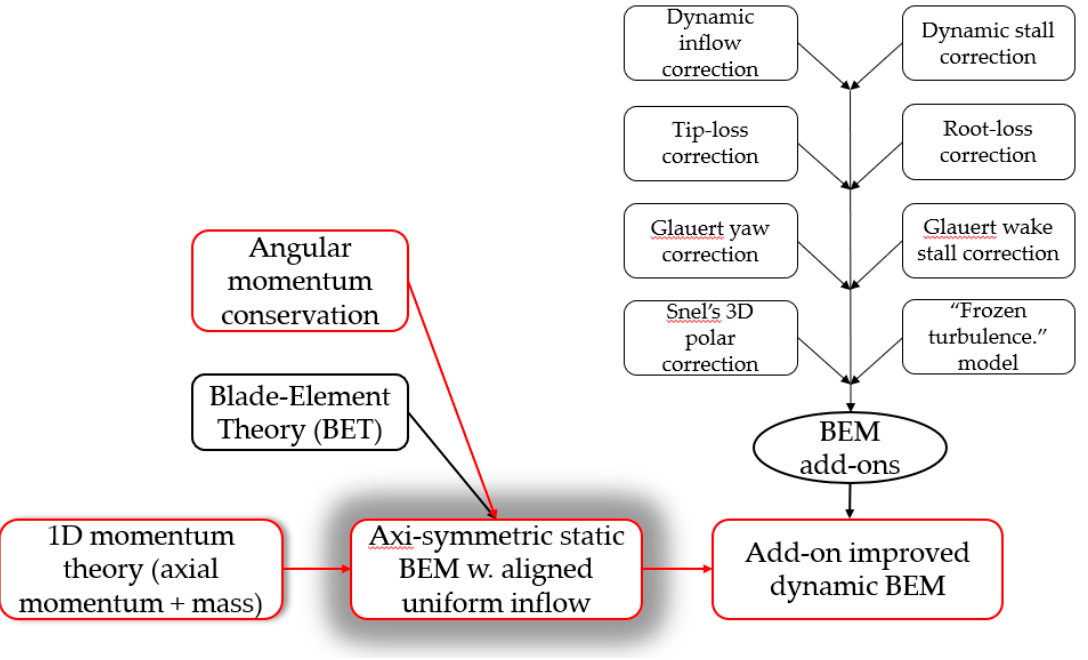
Figure 1. Constituents of the BEM model. The shaded box indicates the part of the BEM model which is modelled and corrected in this work. The four red boxes indicate the chain of dependency for the momentum conservation corrections.